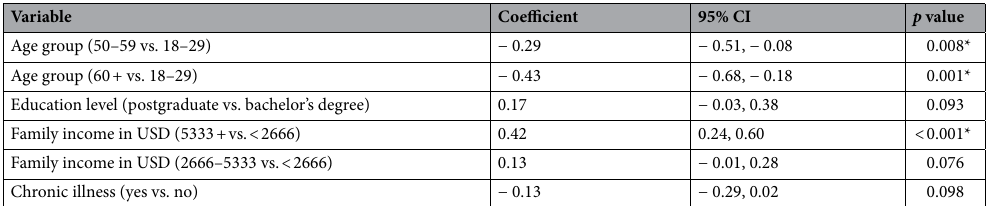
Table 3. Multiple linear regression on factors associated with handwashing knowledge. Other variables (age group 30–39 vs. 18–29 years, 40–49 vs. 18–29 years; gender; ≤ secondary school vs. bachelor’s degree) were not mentioned in the table (p > 0.1). *p < 0.05.